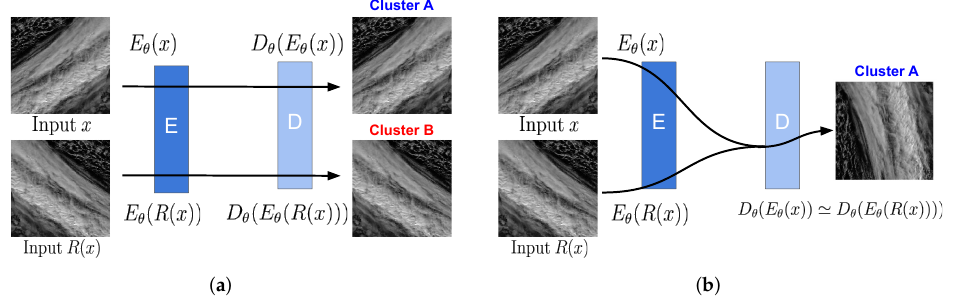
Figure 2. Illustration of the learning process when training ( a ) a conventional autoencoder with Equation (1) vs. ( b ) a rotation-invariant autoencoder with Equation (2). Because a conventional autoencoder reflects orientation in the latent representation, two input images that are identical in texture but different in orientation are assigned to different clusters, A and B. The rotation-invariant autoencoder produces a latent representation that is agnostic to orientation, allowing clustering to group both